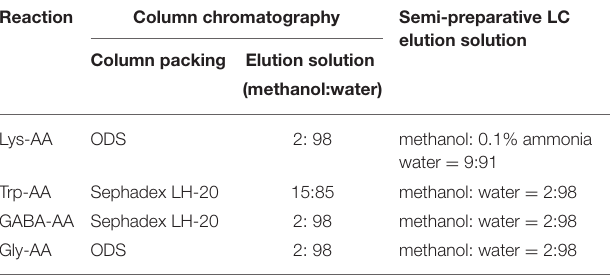
TABLE 2 | Qualitative ion pair, quantitative ion pair and optimized voltage.